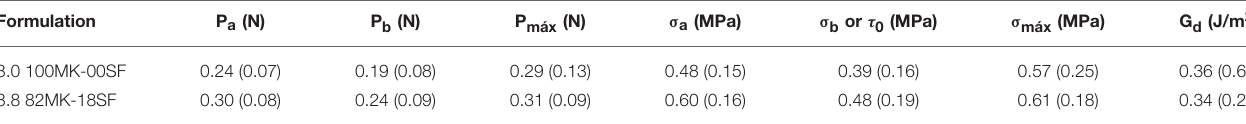
FIGURE 9 | Pullout curves for PVA fibers embedded (Le TABLE 3 | Main parameters obtained in the single fiber pullout test for two alkali-activated matrices with different SiO 2 /Al 2 O 3 ratios. Formulation